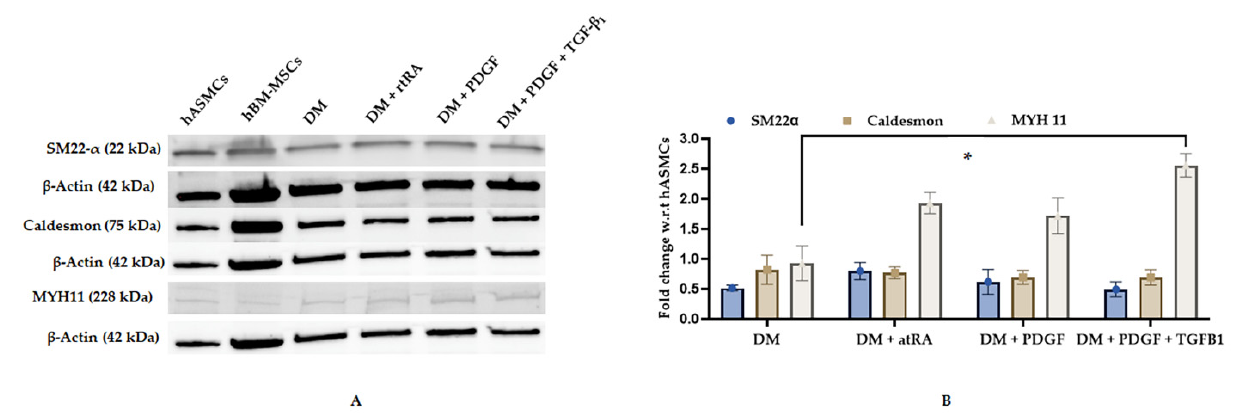
Figure 1. Western Blot Analysis for various SMC markers of M3 cell linesubjected to different differentiation medium (DM) treatments. hBM-MSCs were plated onto fibronectin-coated T175 flasks and treated for four days with DM, DM with all-trans retinoic acid (DM + atRA), DM with platelet-derived growth factor-BB (DM + PDGF), and DM with PDGF and transforming growth factor- β 1 (DM + PDGF + TGFB1), respectively. Western blot analysis was performed for smooth muscle cell markers ( A ) SM22- α , caldesmon, and smooth muscle myosin heavy chain-11 (MYH11). Fold change was determined with respect to DM treatment ( B ). The treatment (DM + PDGF + TGFB1) showed a statistically significant increase in MYH11 (B) expression (*- p -value < 0.05).